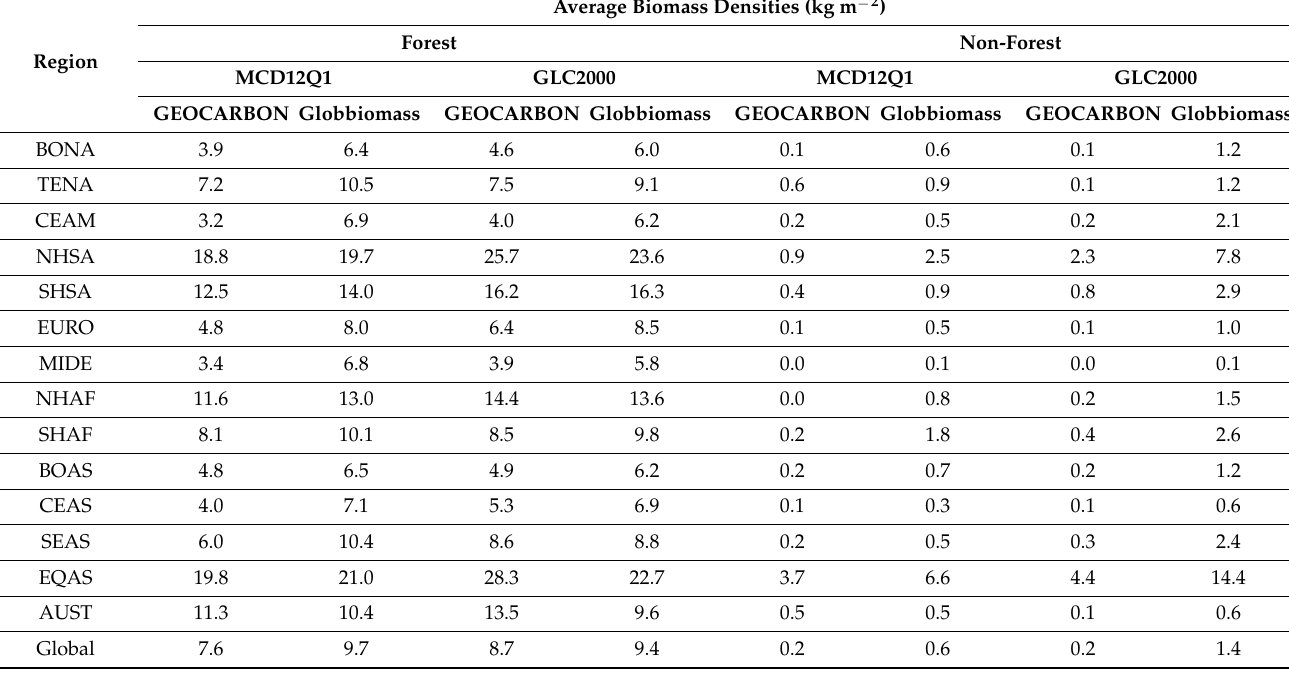
Table 5. Average biomass densities of forest and non-forest areas in each AGB product based on two LCC maps.